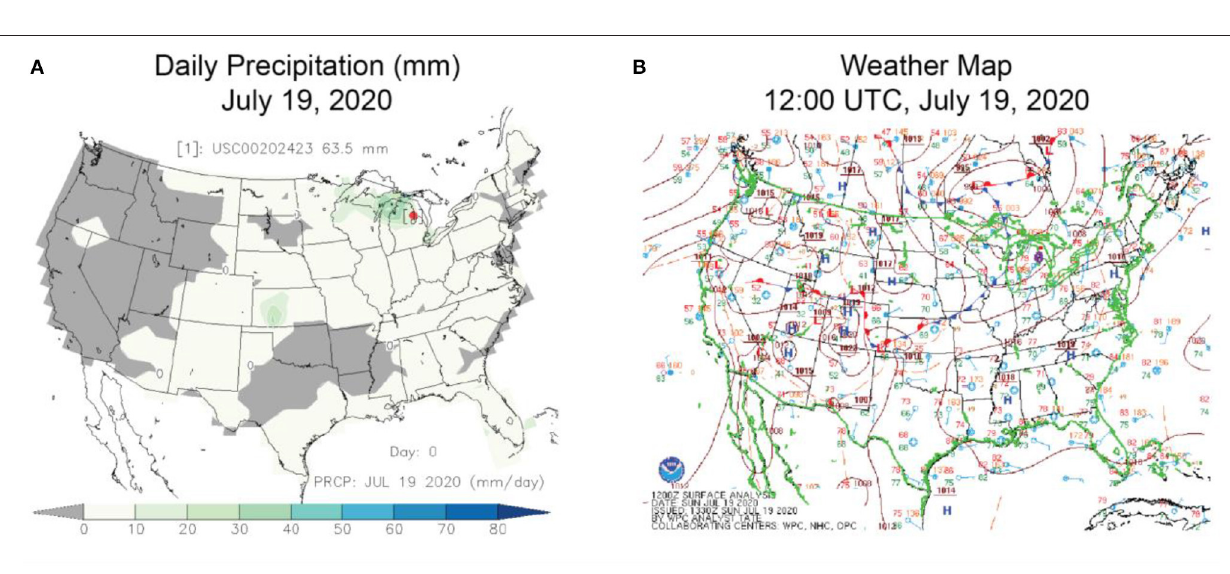
FIGURE 4 | Weather maps including (A) map of daily precipitation (mm) and (B) map of weather features, for a day (July 19, 2020) with one extreme event caused by a mesoscale convective system (MCS). The red dot in (A) and the white-on-purple number in (B) indicate the location of the